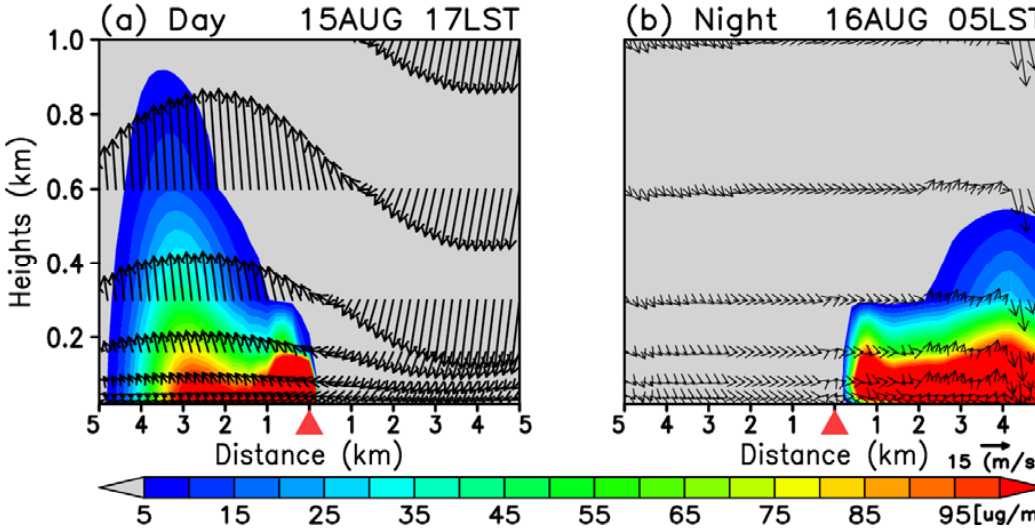
Figure 4. Vertical cross ‐ section of benzene concentration (shading) along the surface wind direction at the source point. The concentration at ( a ) 17:00 LST 15 August, which is three hours after the daytime emission started at 14:00 LST, and at ( b ) 05:00 LST 16 August, 3 h after the nighttime emission started at 02:00 LST. The x ‐ axis indicates the distance in km from the emission center and the y ‐ axis the vertical height in km from the ground. The exact lines for each vertical cross ‐ section are taken along the red and purple lines in Figure 1 for the daytime and the nighttime emission ‐ started cases, respectively. Wind (arrow) and the source point (red triangle) are indicated in each figure. Note that the vertical motion is exaggerated by multiplying the vertical wind component by 100.